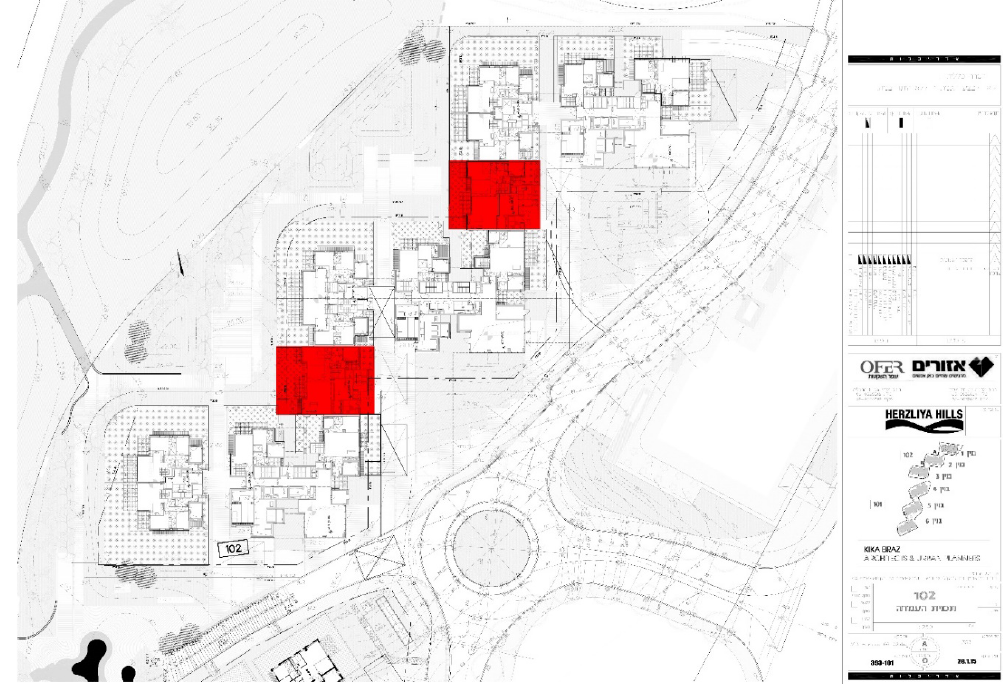
Figure 5. Ground floor plan with the ‘boutique buildings’ in red. Source: K. Braz private collection